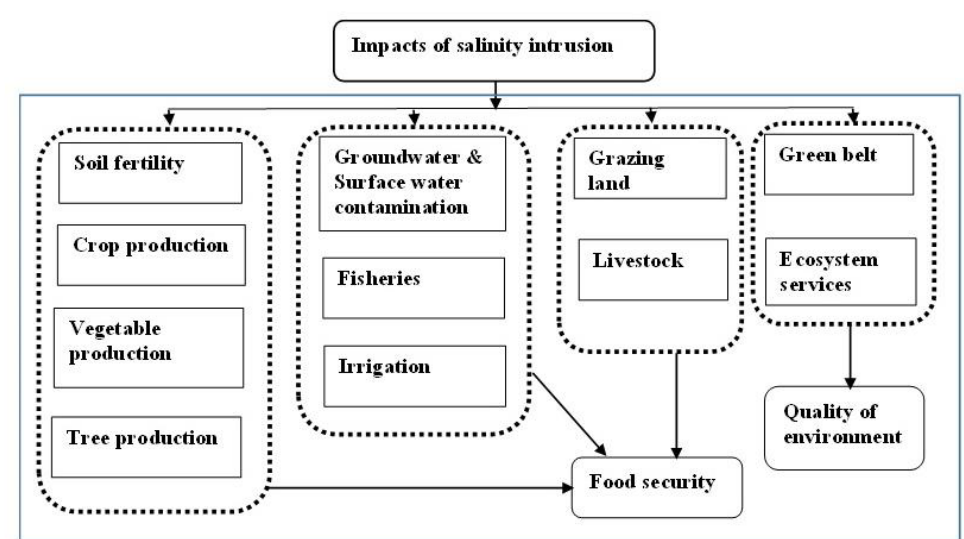
Figure 5. A summarized impact of salinity on crop production and the subsequent impact on food security (Source: Authors, 2022).